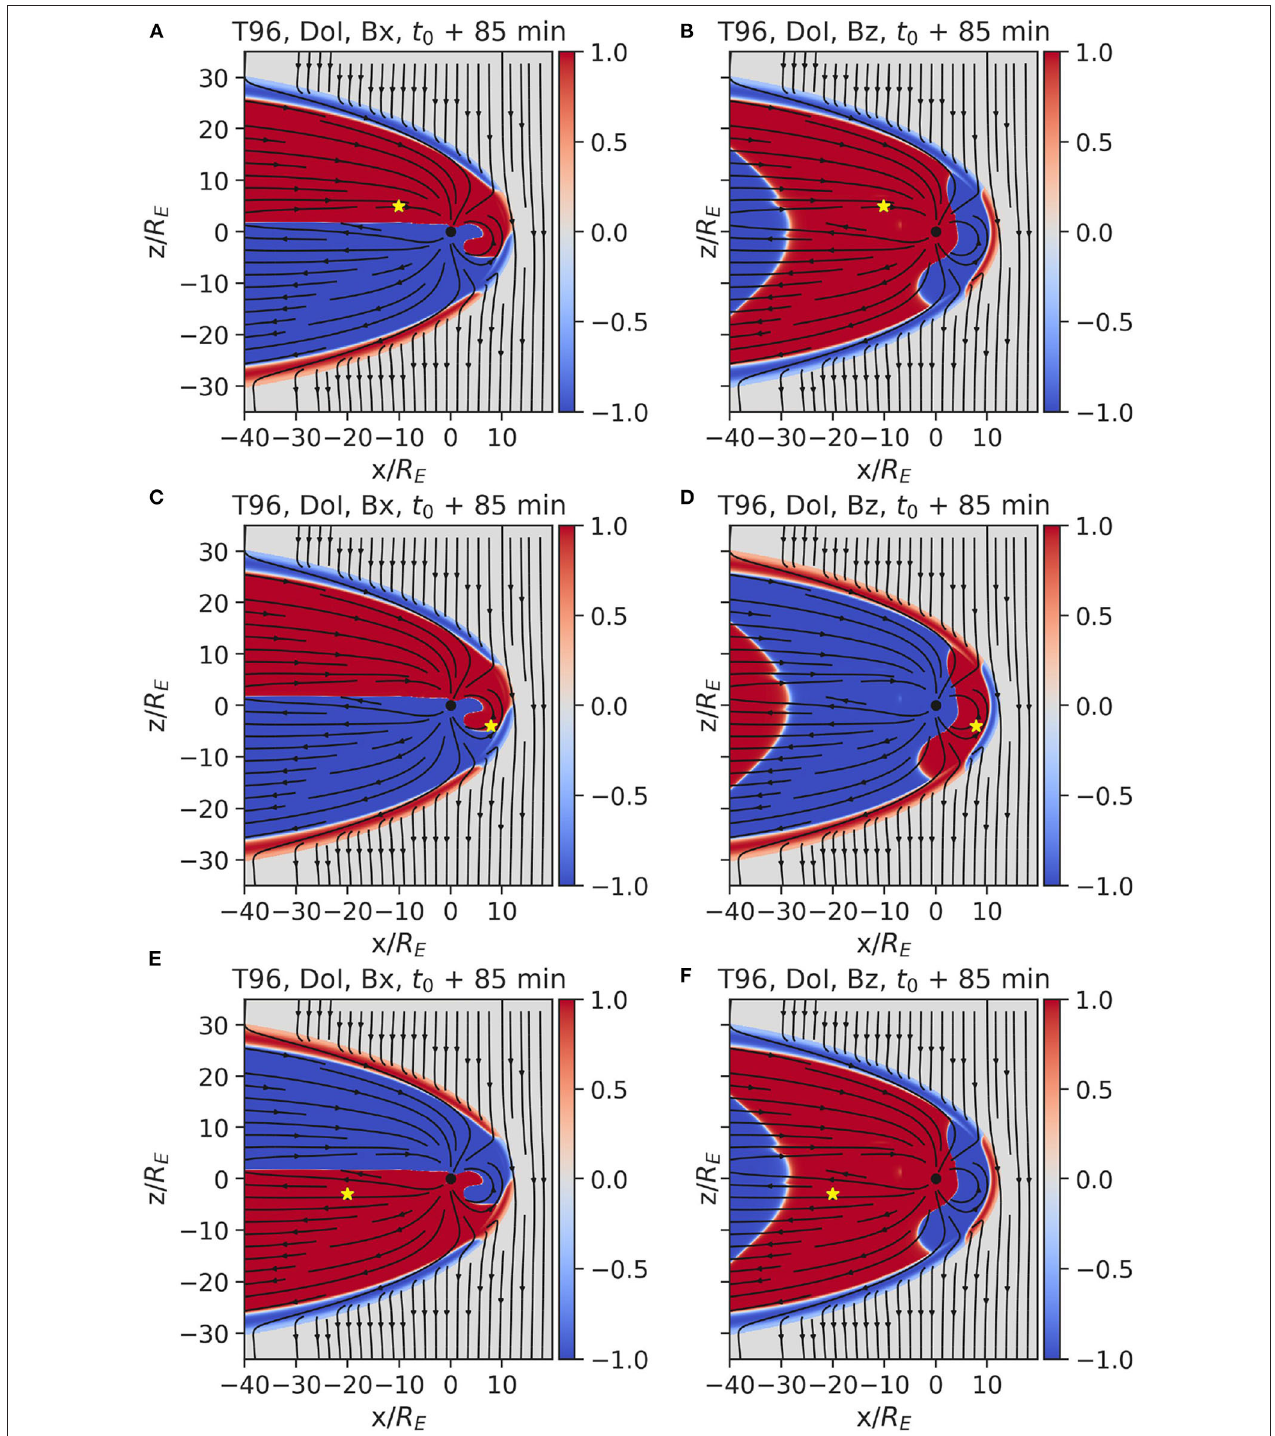
FIGURE 7 | Each row displays the DOI maps for B x and B z , from an ensemble of Tsyganenko model T96 simulations with observation point in the plasma sheet (A,B) , dayside magnetosphere (C,D) and southern lobe tail (E,F) , respectively. the variation. Thus, after normalization, only the sign matters, ensemble. The former is due to the fact that the model has i.e., whether a given change at the observation point leads to a no intrinsic time dependence. Any variations of the solar wind positive or negative change at a different affect the entire magnetosphere instantly and in proportion to